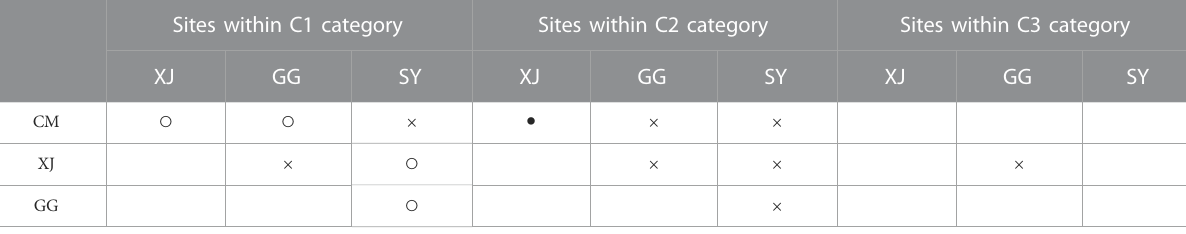
TABLE 2 Trends describing the regional dependency between any two regions for each V S30 -based site category. Sites within C1